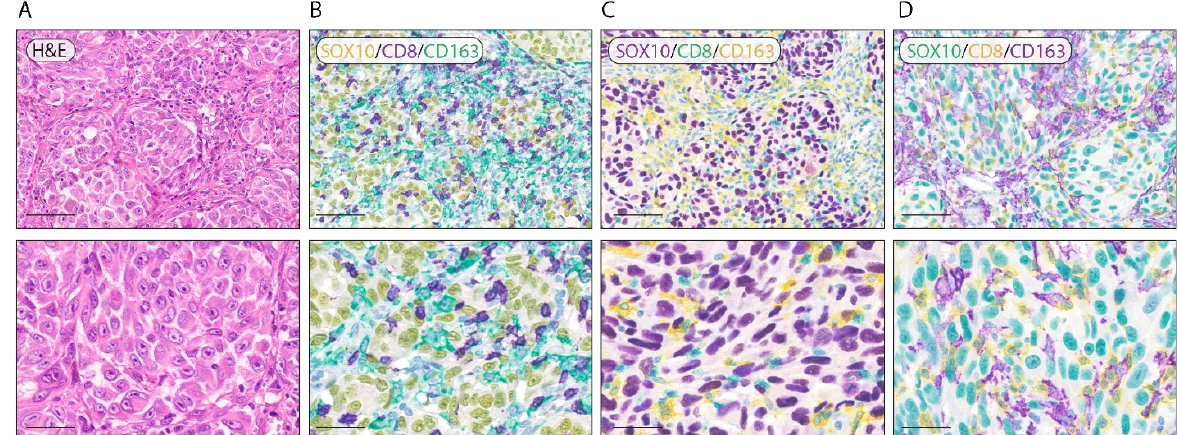
Figure 3. Representative triple-labeling BF multiplex IHC of melanoma tissue. ( A ) Representative images of hematoxylin and eosin staining. ( B ) Representative image of triple SOX10/CD8/CD163 labeling with Yellow (SOX10), Purple (CD8) and Green (CD163) chromogens. ( C ) Representative image of triple SOX10/CD8/CD163 staining with Purple (SOX10), Green (CD8) and Yellow (CD163) chromogens. ( D ) Representative image of triple SOX10/CD8/CD163 staining with Green (SOX10), Yellow (CD8) and Purple (CD163) chromogens. Counterstain was performed with hematoxylin. Magnification: 200× and 400× (scale bar: 100 µm and 50 µm).